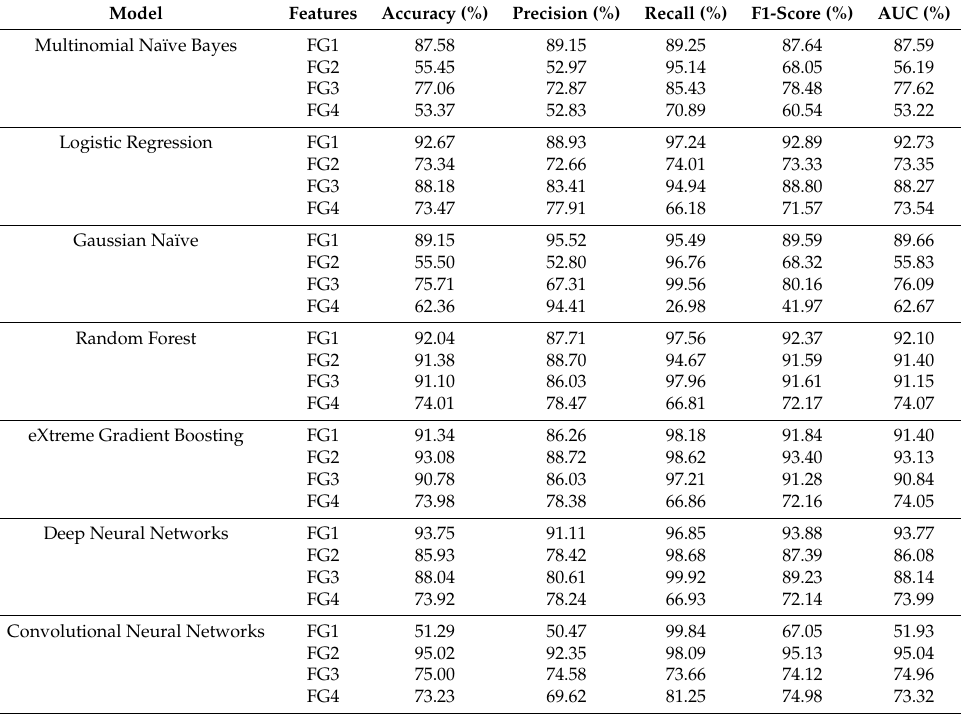
Table 5. The results of the classification models on